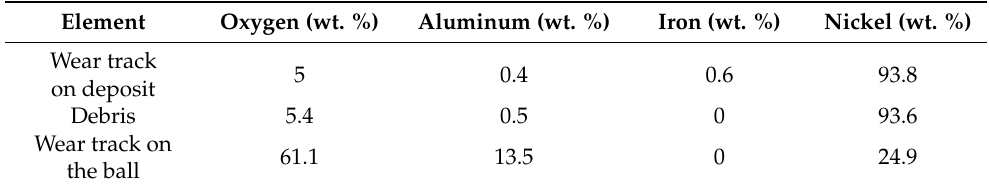
Table 6. Chemical composition of the wear track on the heat-treated deposit, debris, and ball after the dry ball-on-disk sliding test. Element Oxygen (wt.